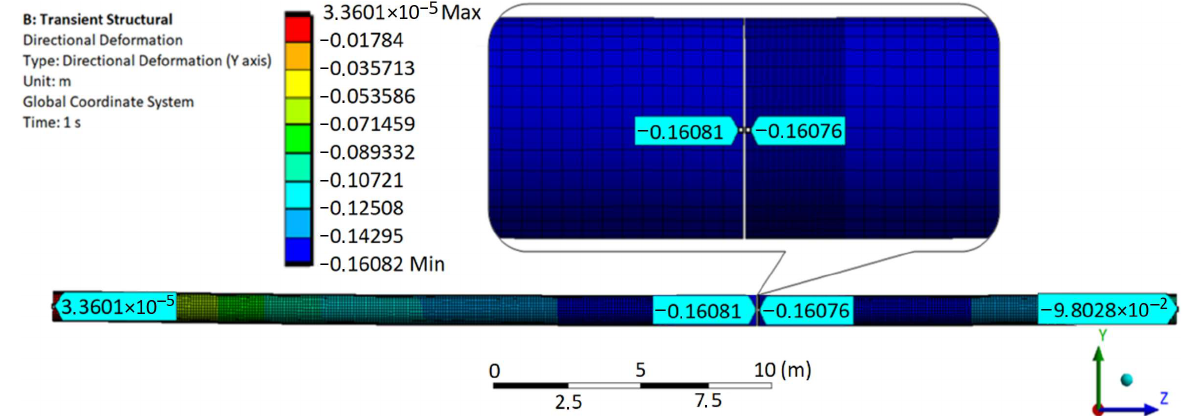
Figure 20. The finite element model of the height position of the pipeline after cutting it while fixing the position of its ends.